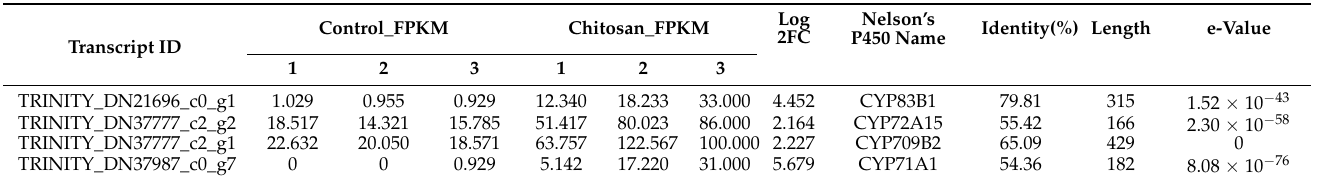
Table 1. Identification of four differentially expressed genes (DEGs) associated with cy- tochrome